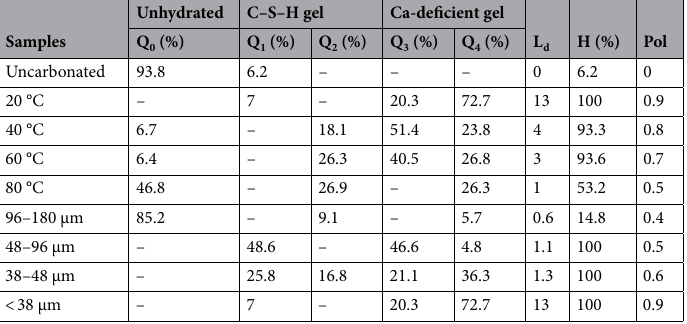
Table 5 lists the calculated deconvolution results from 29 Si NMR analysis. No Q 3 and Q 4 peaks were found to be present before the hydration and carbonation reactions, indicating that it is more difficult to complete C 2 S